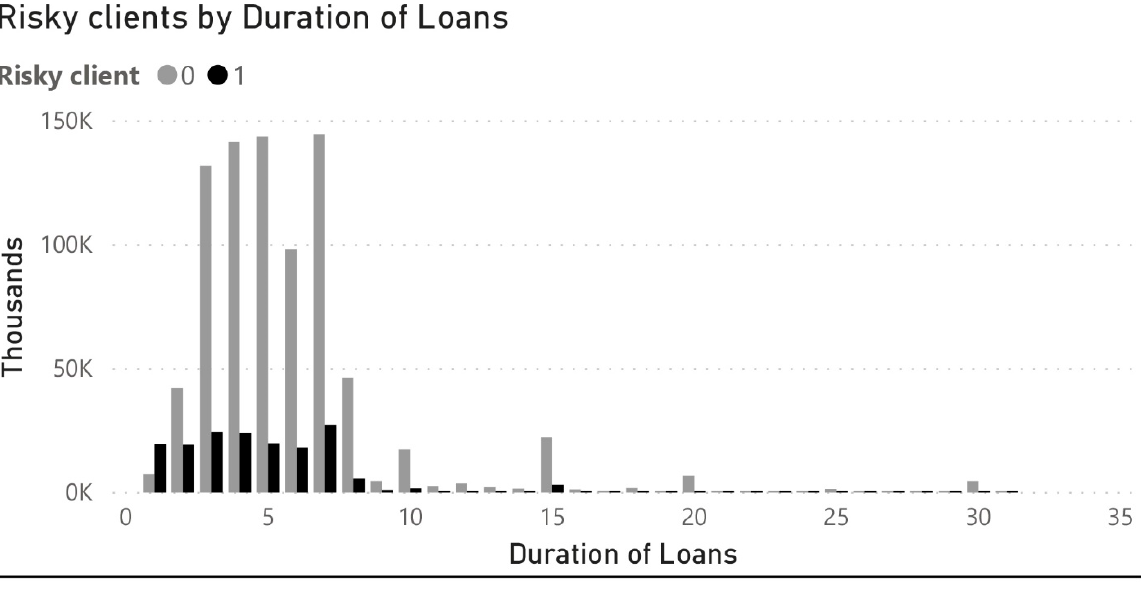
Figure 4. Risk by duration of loans. Figure shows a comparison of total number of borrowers and the risky borrowers depending on the duration of the loan in years.